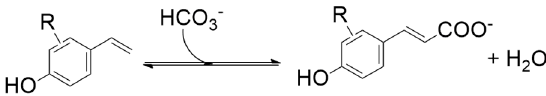
Figure 22. (E/Z)-stereoselective carboxylation of para -hydroxystyrenes to ( E )-4-hydroxycinnamic acids derivatives using phenolic acid decarboxylase enzymes (PAD).